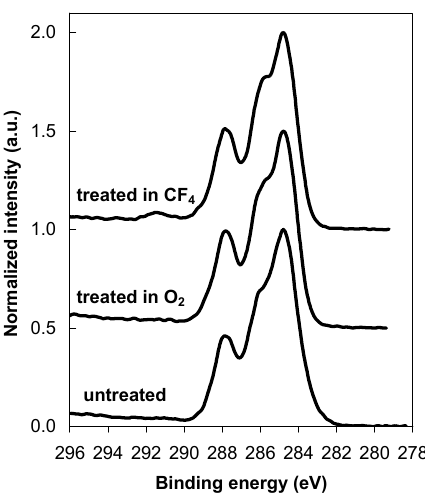
Figure 4. XPS high-resolution spectra of carbon C1s for the untreated sample and both plasma-treated samples after incubation in an albumin solution for 1,000 s.